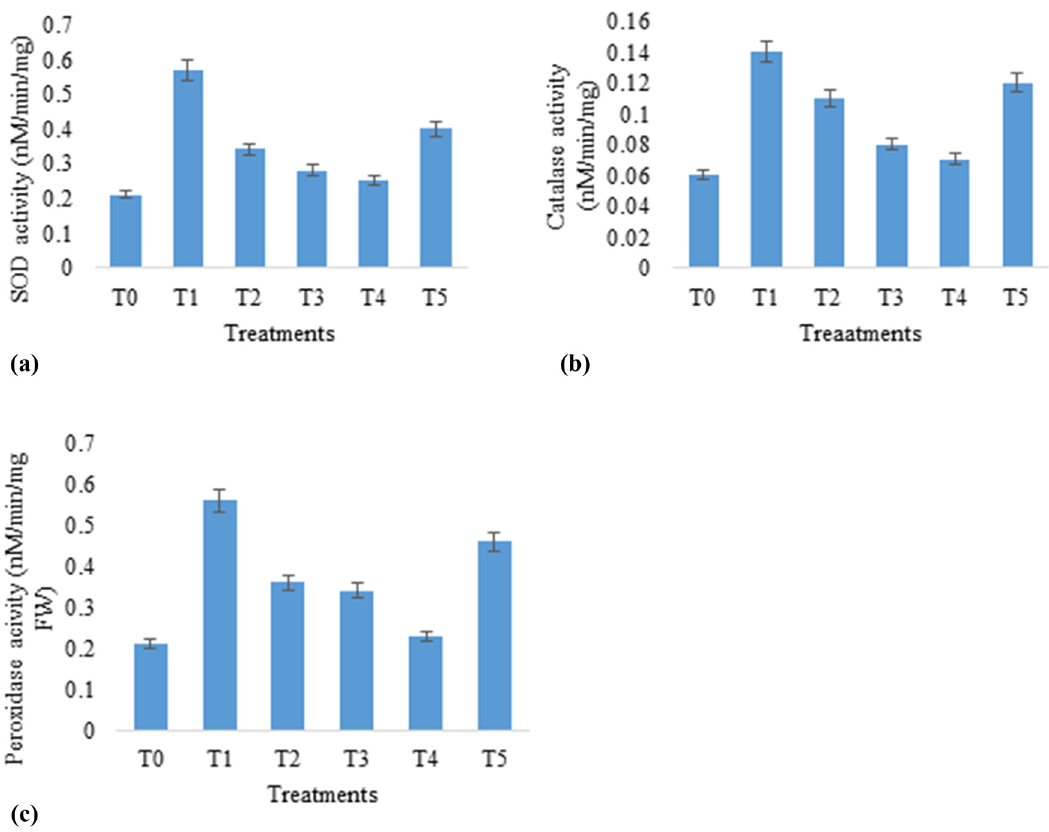
Figure 12: Enzymatic attributes: ( a ) SOD activity, ( b ) CAT activity, and ( c ) POD activity of wheat plants under P. striiformis stress in response to various concentrations of AgNPs: 25, 50, 75, and 100 mg · L − 1 . The data is presented as the mean ± SD from three independent biological replicates. The error term is mean square error = p ≤